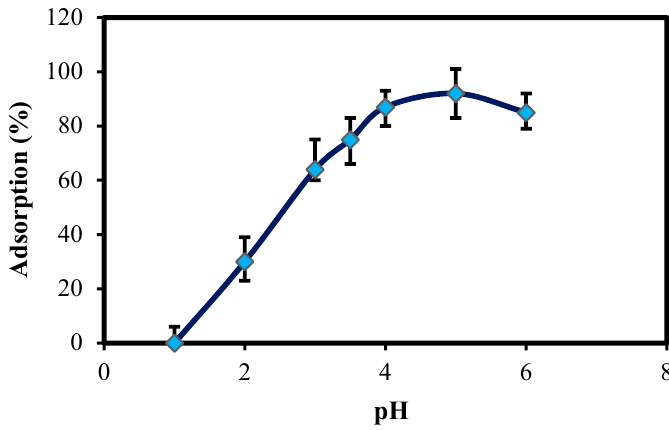
Figure 6. Effect of pH on the Pb(II) adsorption onto ZnO-Nano-A: (initial concentrations of Pb(II), 10 mg L − 1 ; adsorbent mass, 0.1 g L − 1 ; solution volume, 25 mL; temperature, 30 °C; contact time, 1 h).